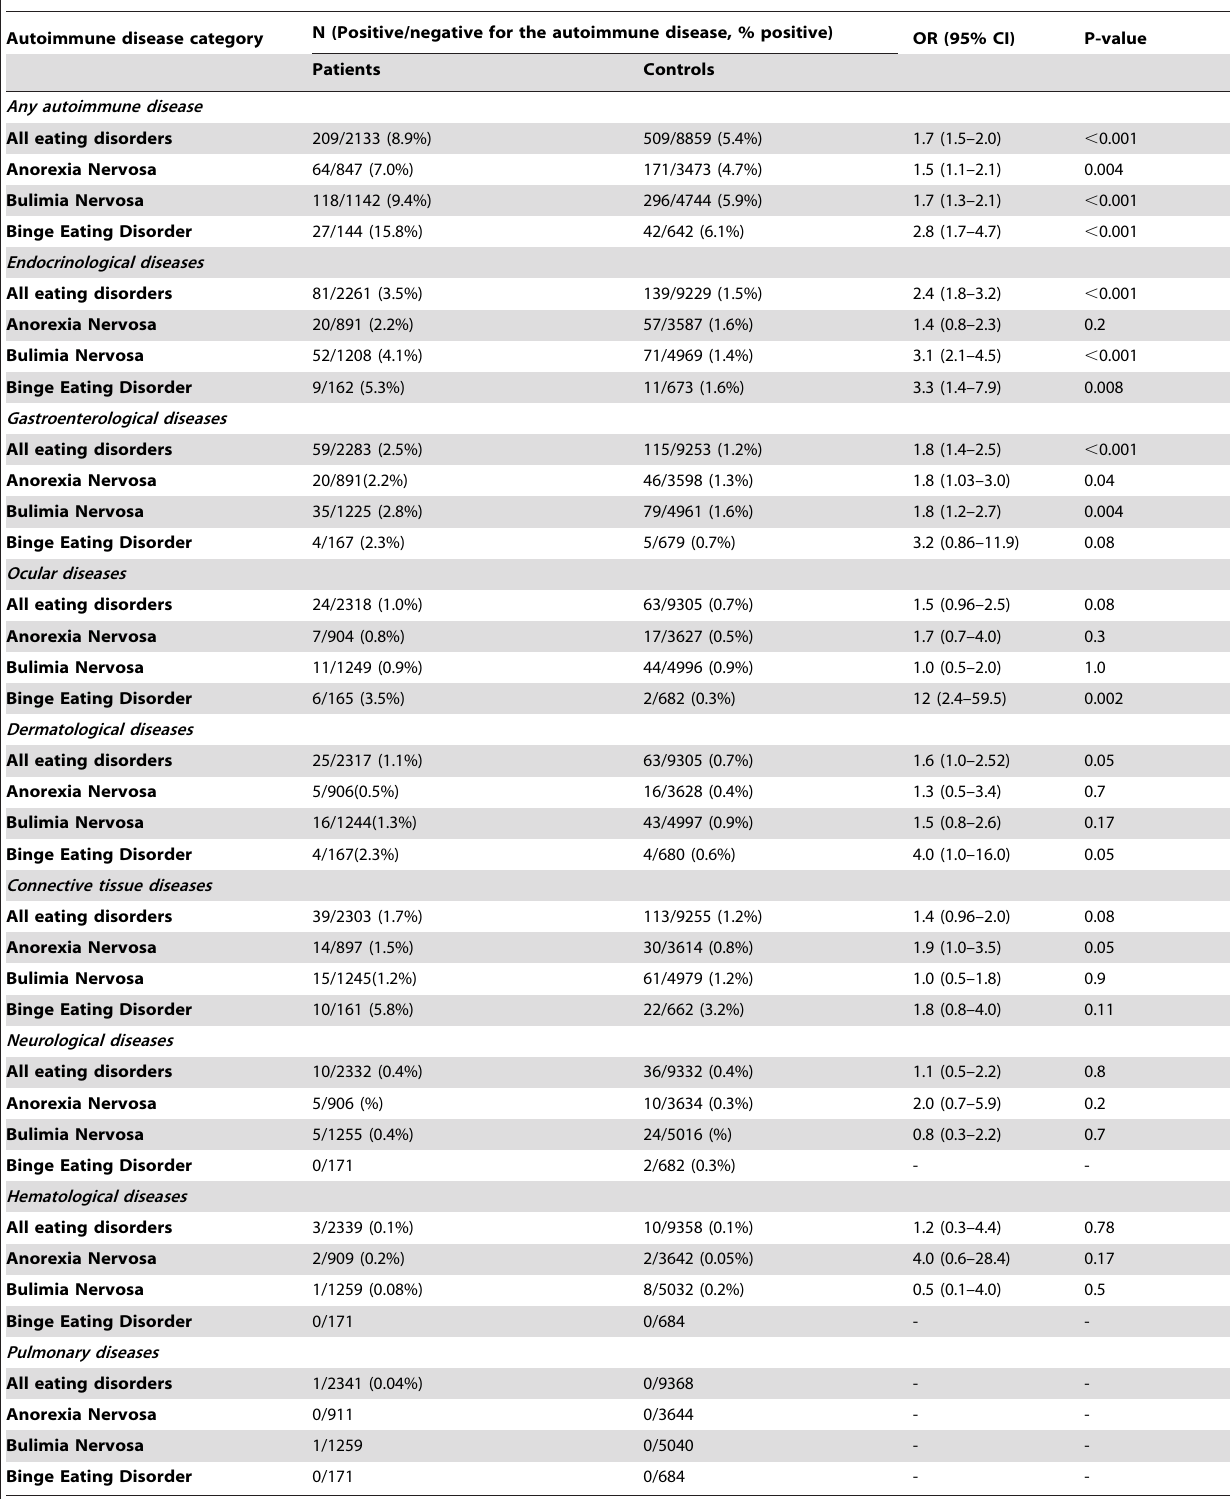
Table 4. Lifetime prevalences of autoimmune diseases, i.e. status at the end of the study period covering the time before, during and after the treatment for an eating disorder in patients with eating disorders compared with their control